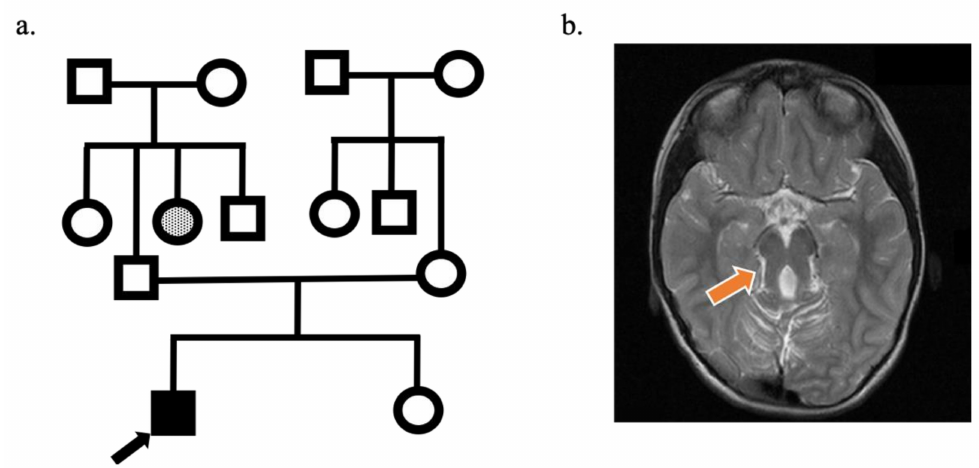
Figure 1. ( a ) Family pedigree of the proband is shown. Proband is the first child of nonconsan- guineous parents. Parents and younger sister are not affected. ( b ) Molar tooth image observed in the brain magnetic resonance imaging of the proband is indicated by the